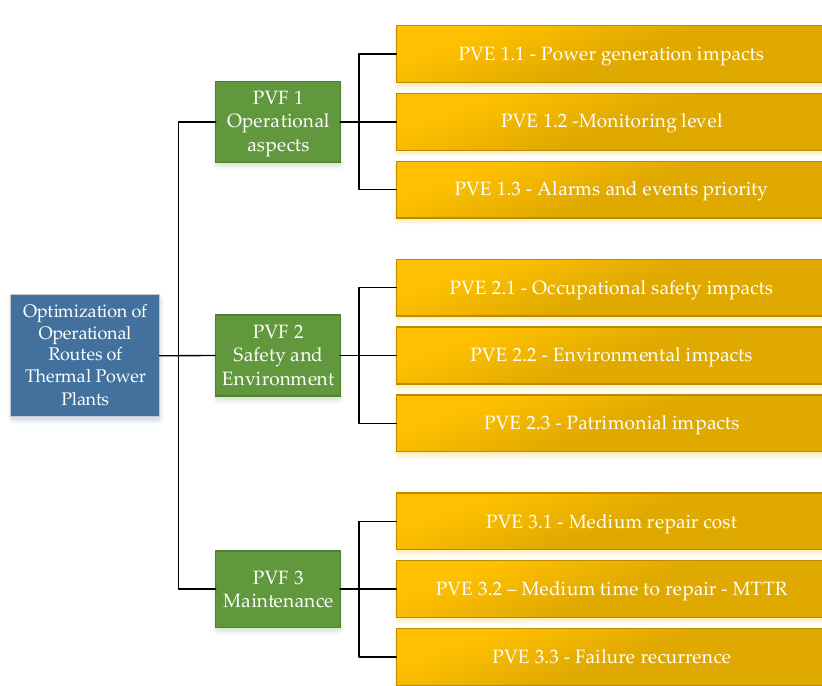
Figure 6. Value Tree of the Evaluation Multi-Criteria Model.